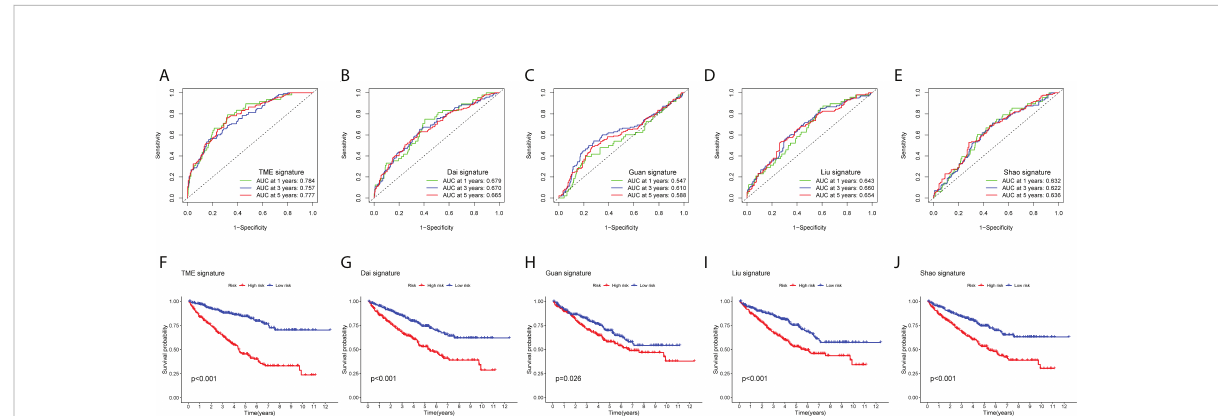
FIGURE 5 Comparison between prognostic models. (A – E) Receiver operating characteristic curves (ROC curves) for the 1-, 3-, and 5-year OS periods. (A) TME-related risk prognostic model, (B) Dai signature, (C) Guan signature, (D) Liu signature, and (E) Shao signature. (F – J) Kaplan – Meier OS curve for high- and low-risk groups. (F) TME-related risk prognostic model, (G) Dai signature, (H) Guan signature, (I) Liu signature, and (J) Shao